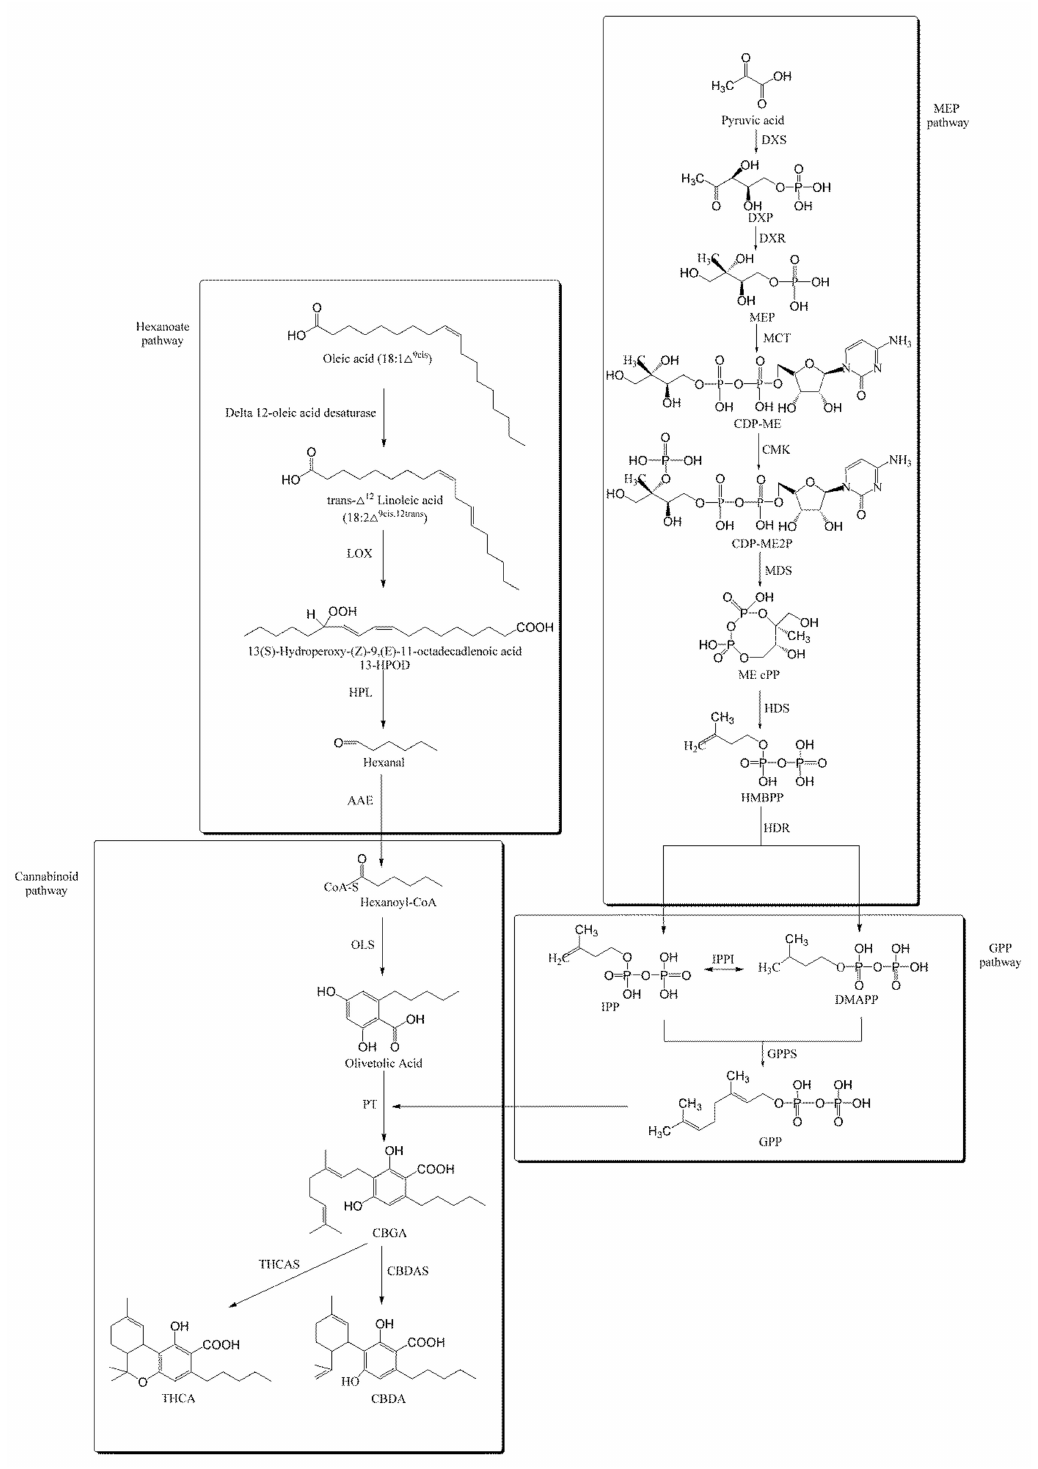
Figure 1. Proposed THCA and CBDA biosynthetic pathway in C. sativa . LOX: lipoxygenase; HPL: hydroperoxide lyase; AAE: acyl-activating enzyme; DXS: 1-deoxy- D -xylulose-5-phosphate synthase; DXR: 1-deoxy- D -xylulose 5-phosphate re- ductoisomerase; MCT: 2-C-methyl- D -erythritol 4-phosphate cytidylyltransferase; CMK: 4-diphosphocytidyl-2-C-methyl- D - erythritol kinase; MDS: 2-C-methyl- D -erythritol 2,4-cyclodiphosphate synthase; HDS: 4-hydroxy-3-methylbut-2-en-1-yl diphosphate synthase; HDR: 4-hydroxy-3-methylbut-2-enyl diphosphate reductase; IPPI: Isopentenyl diphosphate iso- merase; GPPS: Geranyl diphosphate synthase; OLS: olivetol synthase; PT: prenyltransferase; THCAS: tetrahydrocannabinolic acid synthase; CBDAS: cannabidiolic acid